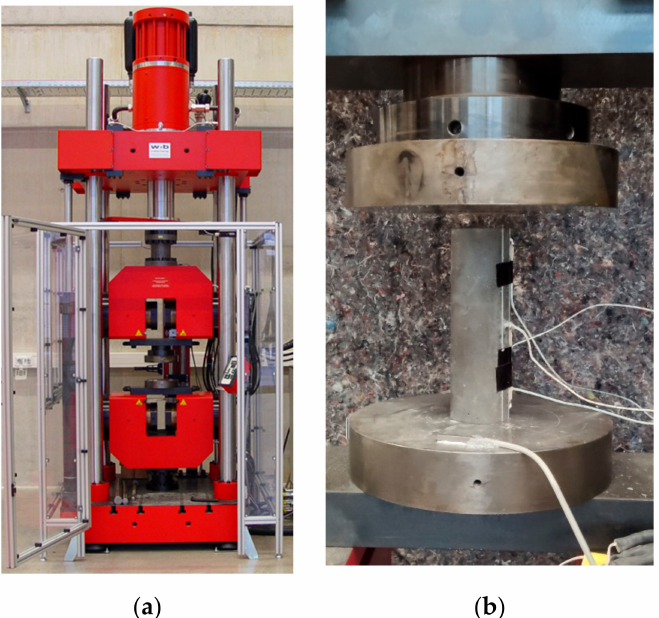
Figure 1. ( a ) Servo-hydraulic testing machine in the laboratory in Weimar; ( b ) UHPC sample in this testing